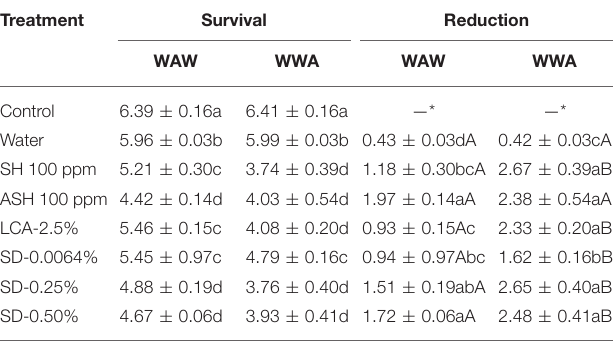
TABLE 4 | Survival and reduction of L. monocytogenes on tomatoes (log CFU/tomato) by triple-wash procedure WAW or WWA in water, SH (100 ppm, pH